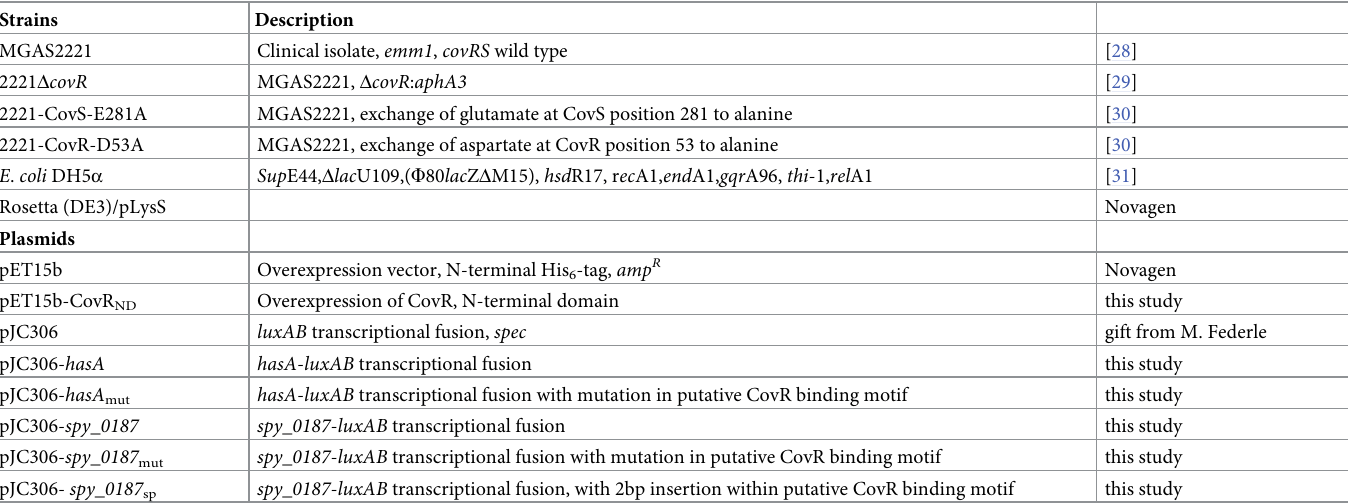
Table 1. Strains and